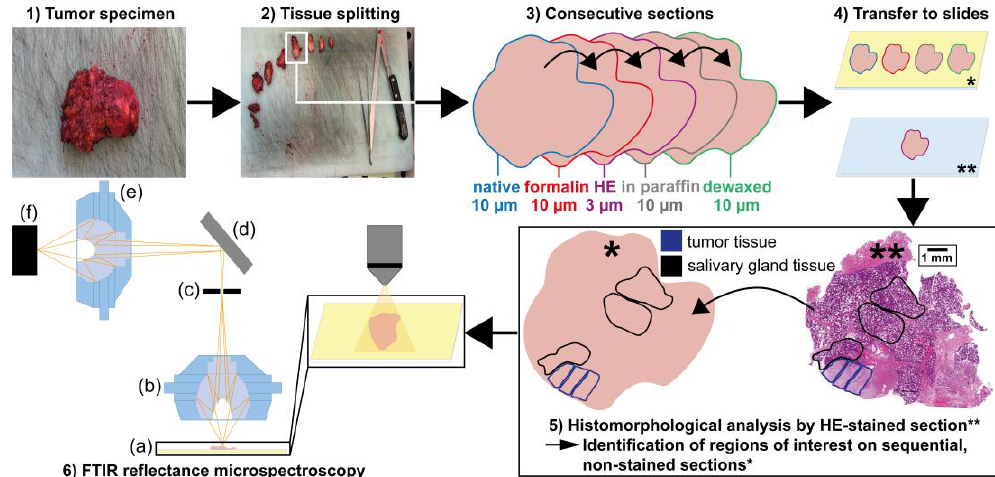
Figure 1. Workflow of tissue preparation for FTIR microspectroscopic measurements. Salivary gland and tumor tissues were resected ( 1 ) and cut into pieces ( 2 ). One tissue piece was chosen and prepared according to four different preparation protocols (“native”, “formalin”, “in paraffin” and “dewaxed”) and complemented with a separate HE staining ( 3 ). Cross-sections were prepared and mounted onto gold-coated objective slides for the four different preparation protocols for microspectroscopy ( 4* ) and onto glass slides for the HE staining and conventional microscopic analysis ( 4** ). The asterisks * is used to highlight the gold-coated objective slides, ** for the glass slides. The HE-stained sections were used to identify regions of interest on sequential non-stained sections ( 5 ). Finally, the “native”, “formalin”, “in paraffin” and “dewaxed” cross-sections were measured in reflectance mode with a FTIR microspectrometer ( 6 ): in ( a ) tissue sample on a gold-coated slide, ( b ) Cassegrain objective, ( c ) remote aperture position, ( d ) mirror for excitation and detection light path, ( e ) Cassegrain MCT, ( f ) MCT detector.